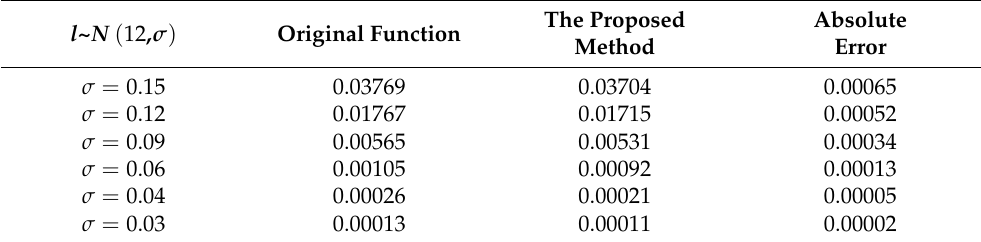
Table 7. Convergence analysis result of the errors with respect to the failure